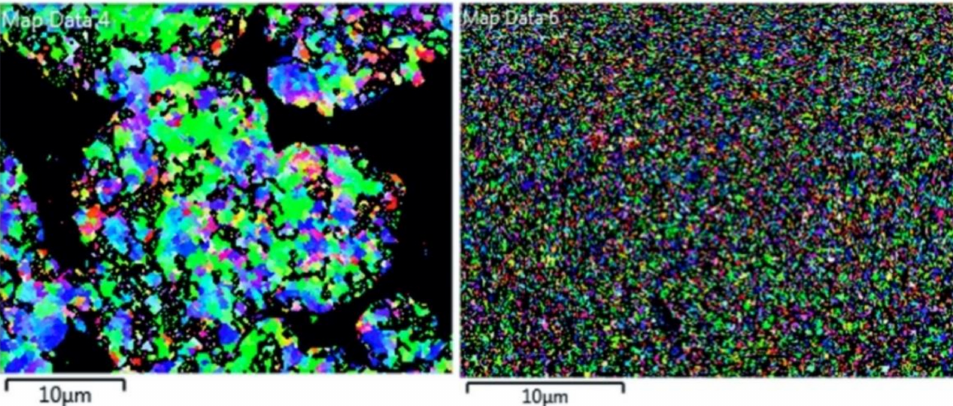
Figure 15. ( Left ) presents the EBSD-derived crystallographic analysis of the conventional cold spray coating in the orthogonal orientation. ( Right ) presents the EBSD derived crystallographic analysis of the nanostructured cold spray coating in the orthogonal